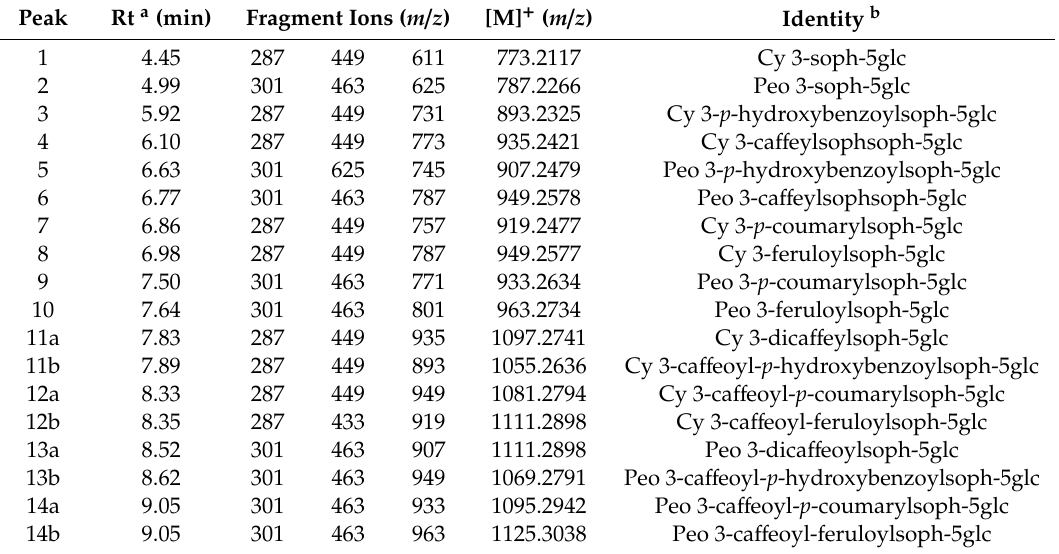
Table 1. Identification of anthocyanins (1–14) from cultivar Fushu No. 23 and cultivar Fushu No. 317 leaves using ultra performance liquid chromatography / quadrupole time-of-flight mass spectrometry (UPLC-QTOF-MS /